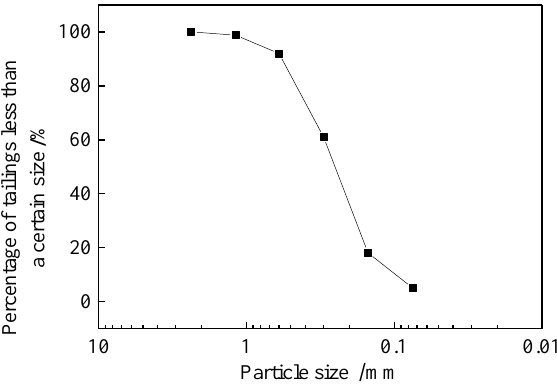
Figure 2. Gradation curve of tailing sand.